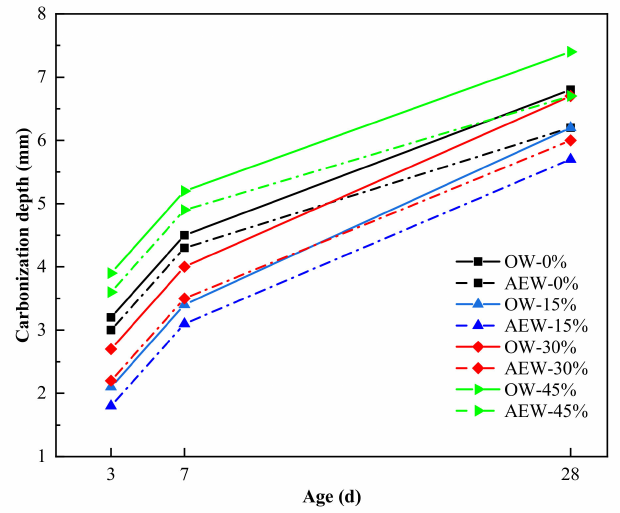
Figure 17. Effect of OW and AEW with a pH value of 11.5 on the carbonation resistance of concrete with different FA replacements at different